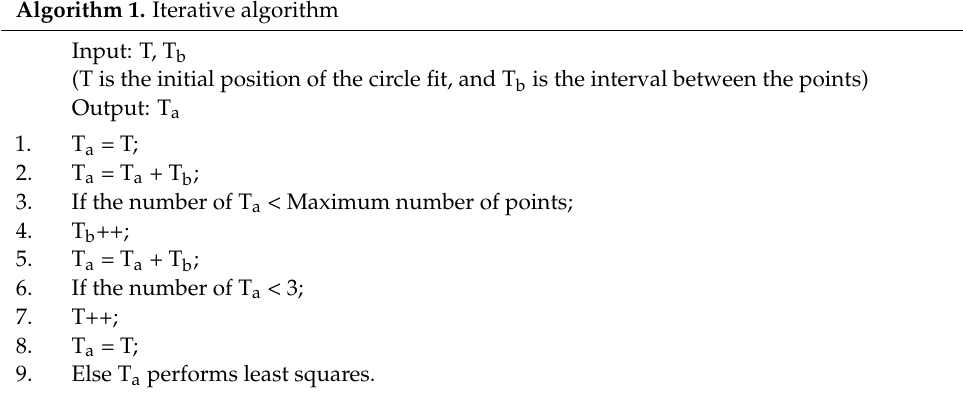
Algorithm 1. Iterative